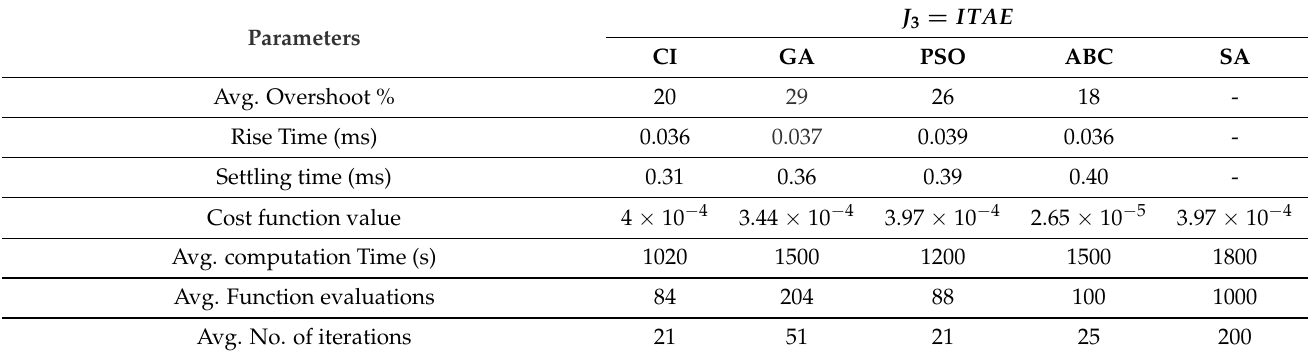
Table 6. Comparison of different optimization methods for the cost function ITAE.